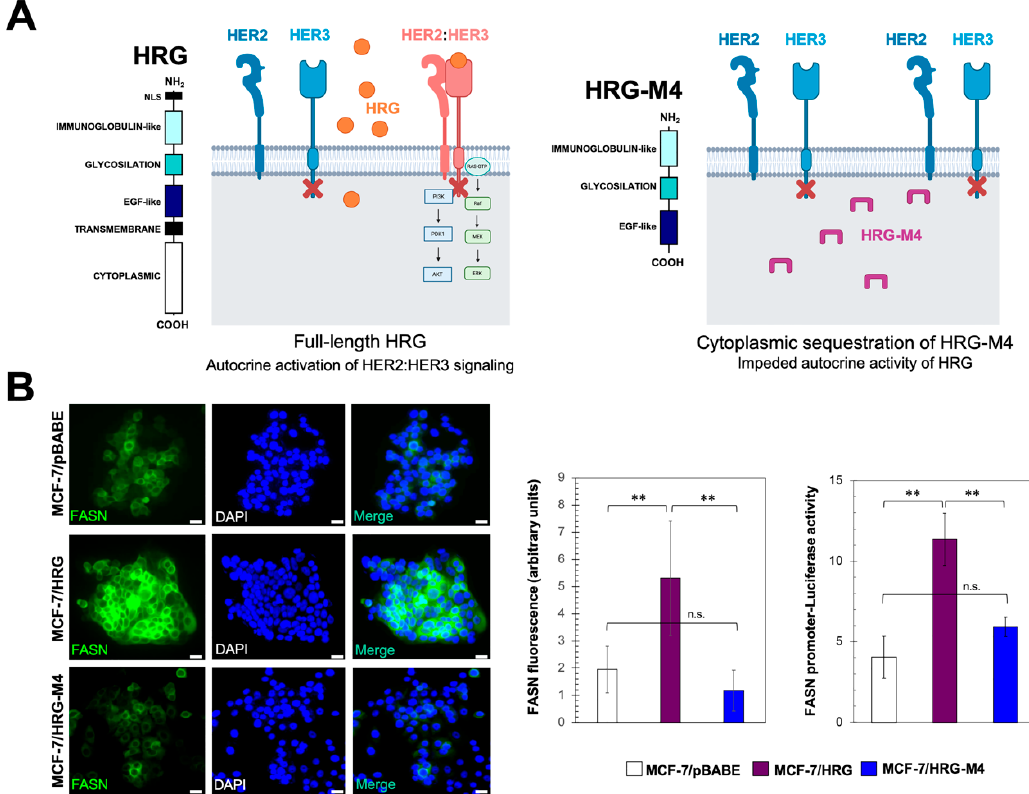
Figure 1. Luminal breast cancer cells engineered to overexpress the HER3 ligand heregulin up-regulate FASN expression. ( A ) The structural deletion mutant HRG-M4 su ff ers a cytoplasmic sequestration that impedes the natural autocrine capacity of full-length HRG to promote the trans-phosphorylation of the HER3 receptor within HER2:HER3 heterodimers. ( B ) Left microphotographs. MCF-7 / pBABE, MCF-7 / HRG, and MCF-7 / HRG-M4 cells were subjected to immunofluorescence staining with an anti-FASN specific antibody as described in “Materials and methods”. Middle panel . FASN fluorescence intensities in MCF-7 / pBABE, MCF-7 / HRG, and MCF-7 / HRG-M4 cells were semi-quantitively analyzed by densitometry. Each experimental value represents the mean FASN fluorescence (arbitrary units, columns) ± S.D. (bars) for all the cells in the images on the left. Right panel. MCF-7 / pBABE, MCF-7 / HRG, and MCF-7 / HRG-M4 cells were transiently transfected with a plasmid containing a Luciferase reporter gene driven by a 178-bp FASN gene promoter fragment harboring a SREBP-binding site, flanked by auxiliary NF-Y and Sp-1 sites (Figure 2). After 48 h, luciferase assays were performed as previously described [20,21]. Each experimental value represents the mean fold-increase (columns) ± S.D. (bars) from at least three separate experiments in which triplicate wells were measured. ** p < 0.005; n.s. not significant. (Scale bar is 10 µ